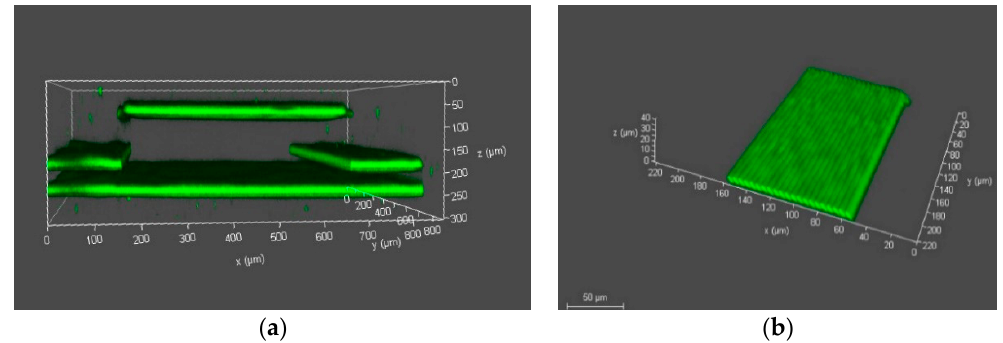
Figure 5. Confocal microscope images of the PDMS microfluidic channel ( a ) and printed wire membrane ( b ).